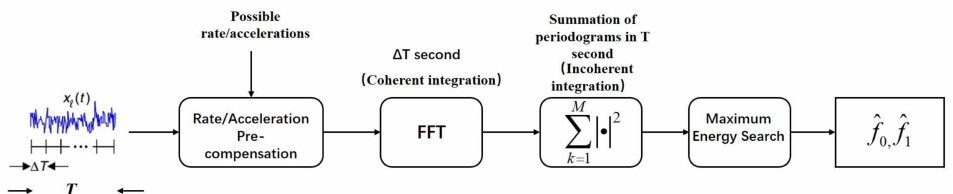
Figure 6. The block diagram of the 2D maximum energy search approach in Mars entry, descent, and landing (EDL)